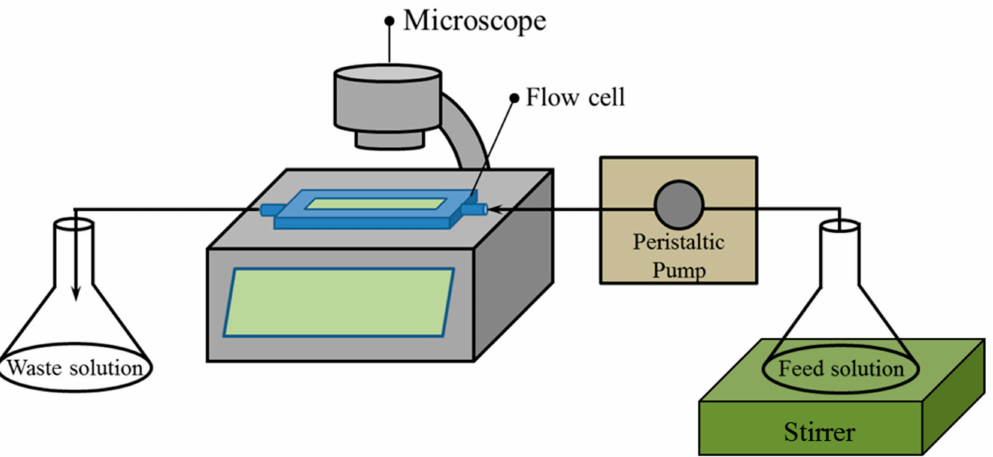
Figure 1. Schematic diagram of the flow cell system for in vitro and real-time observation of biofilm